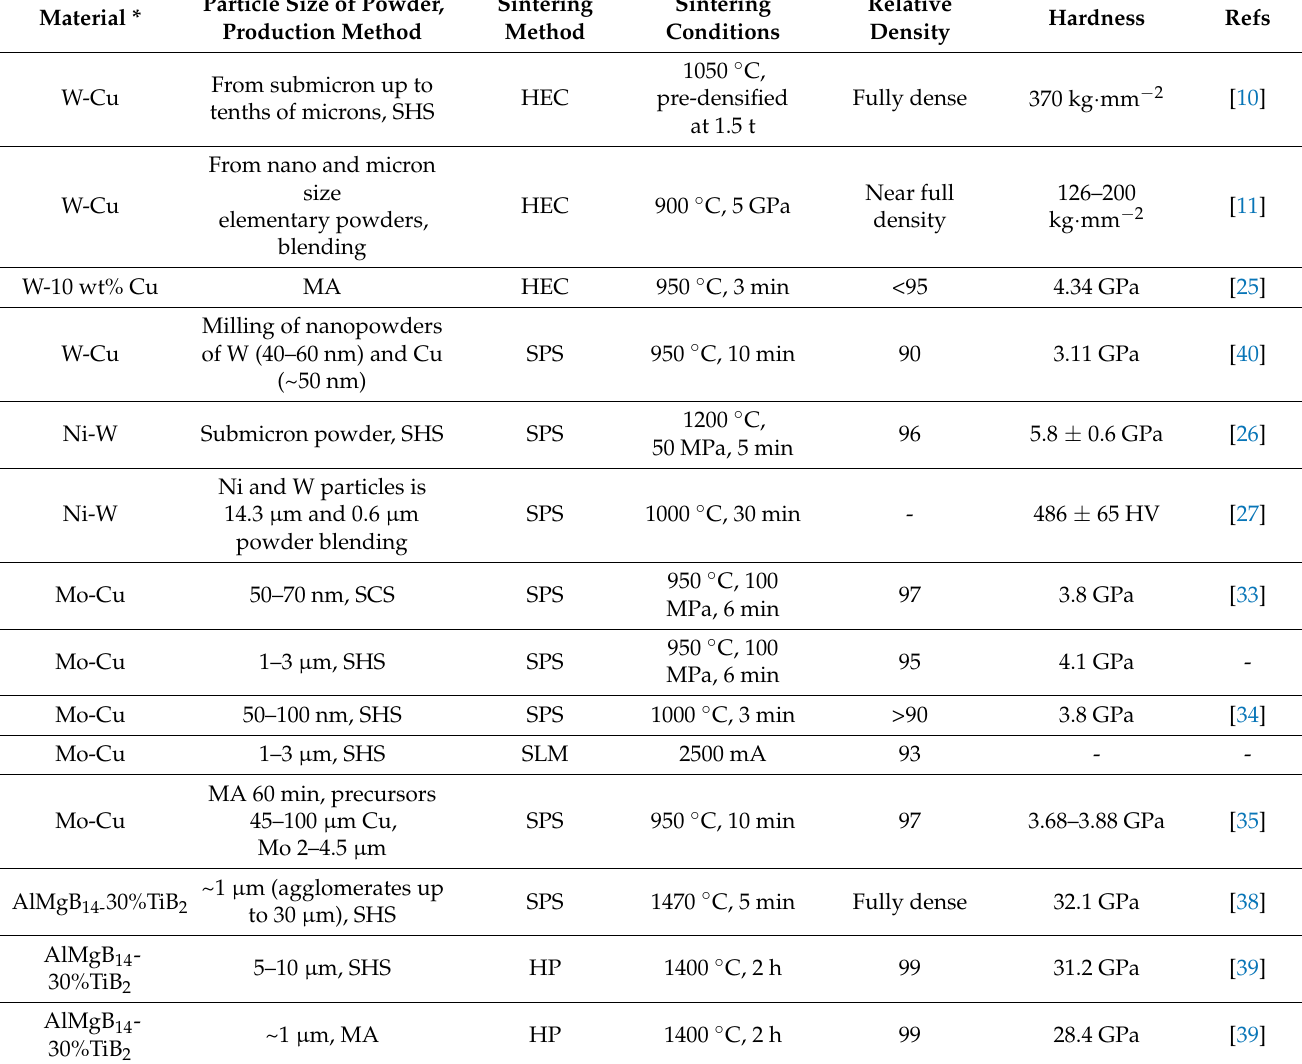
Table 1. Comparative overview of the systems under consideration produced by different methods (SHS-self-propagating high-temperature synthesis, SCS-solution combustion synthesis, MA-mechanical alloying, HEC-hot explosive consolida- tion/compaction, AM-additive manufacturing, HP-hot pressing, SLM-selective laser melting, SPS-spark plasma